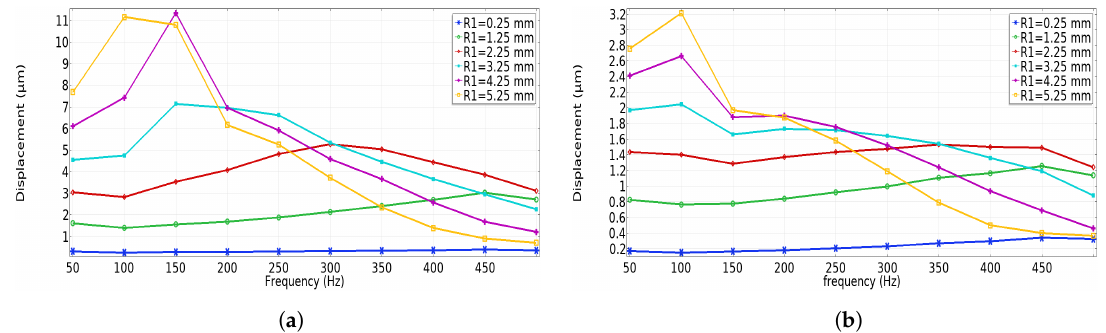
Figure 16. Displacement amplitude versus different pipette radii in the two boundary conditions; ( a ) connected pipette, ( b ) pipette with gap.